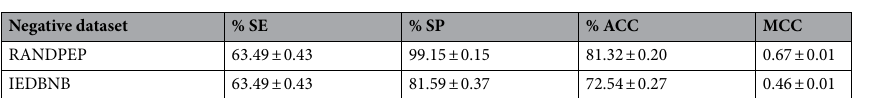
Table 1. Performance of BLAST-based discrimination of B and non-B cell epitopes. Table reports the sensitivity (% SE), specificity (% SP), accuracy (% ACC), and Matthew’s correlation coefficient (MMC) of BLAST-based discrimination of B cell epitopes in BEPIBD from non-B cell epitopes included in the RANDPEP and IEDBNB datasets. Values were obtained in tenfold cross-validation experiments.